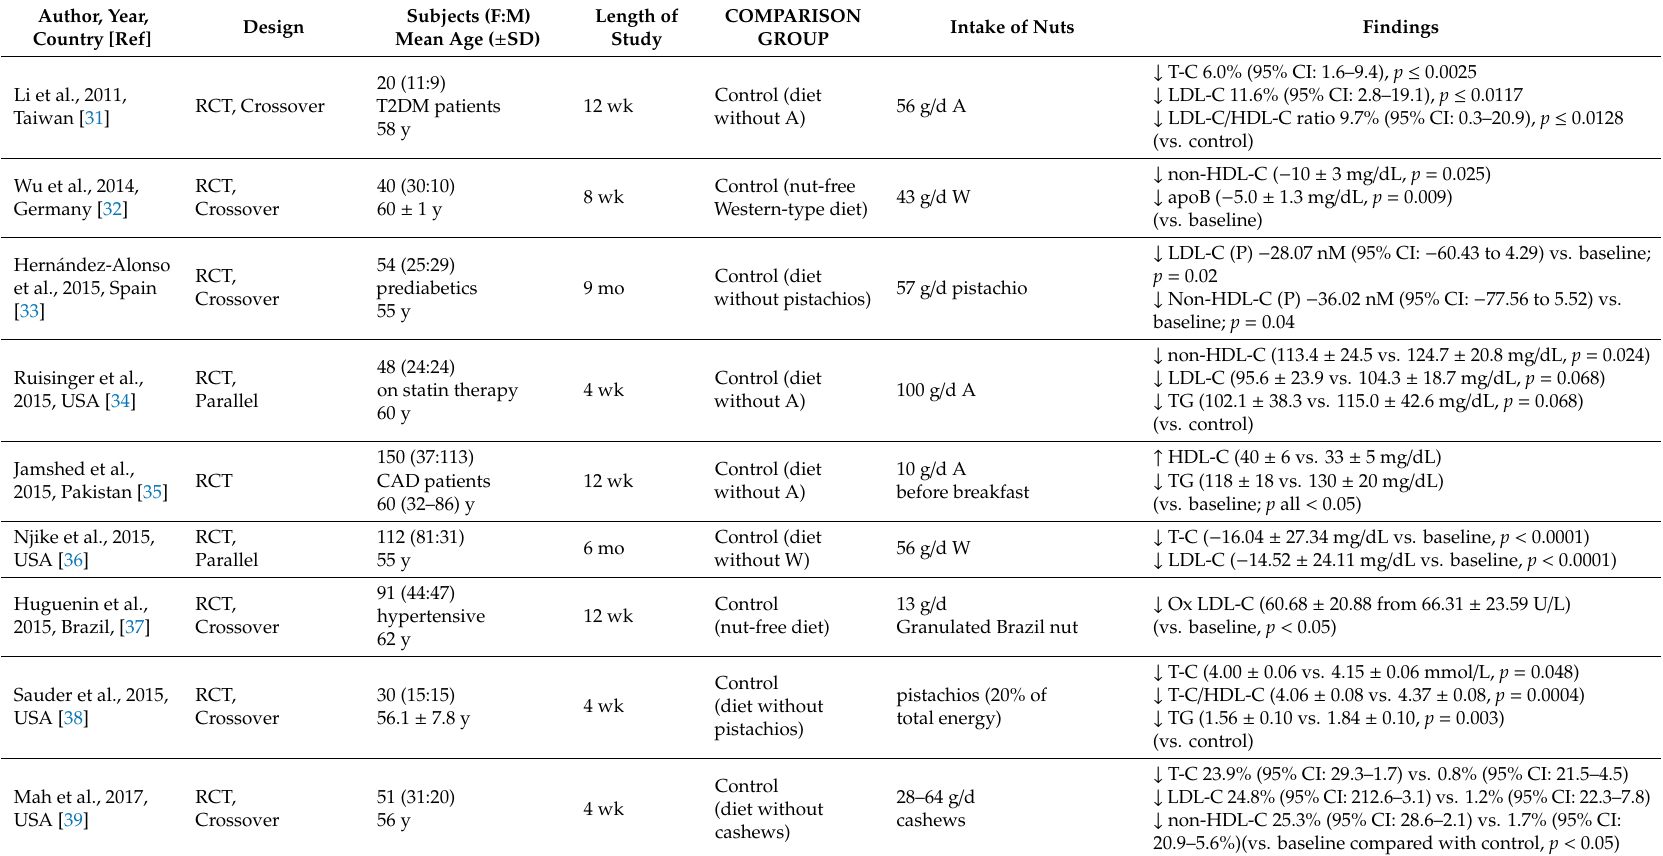
Table 2. Nut consumption and blood lipid levels in intervention